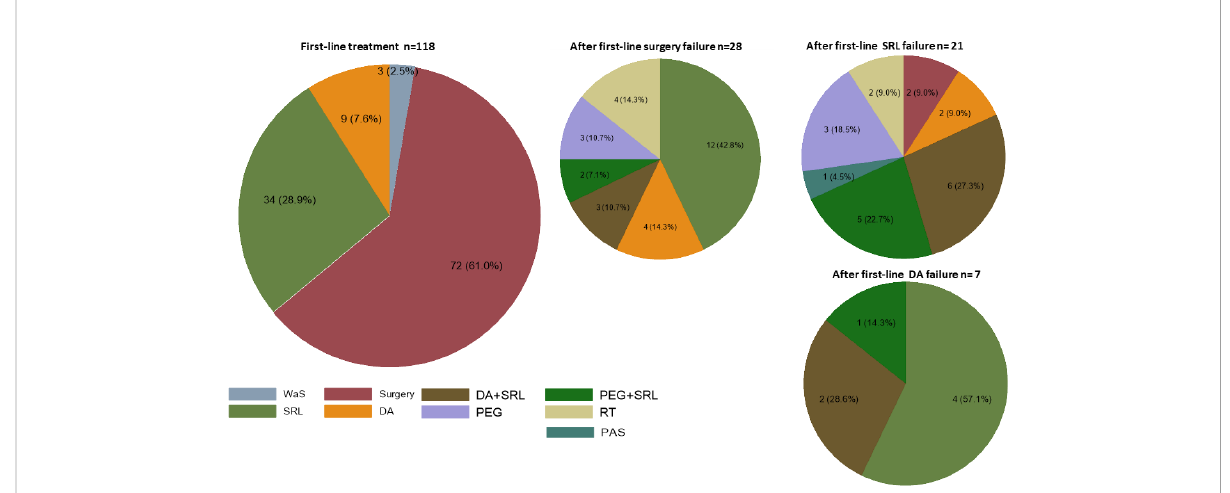
FIGURE 1 Treatment options. First-line on the left and second-line on the right. Results are expressed in “ n ” and percentage. WaS (wait and see) SRL, fi rst generation somatostatin receptor ligand; DA, dopamine agonist ( all cabergoline); PEG, pegvisomant; PAS, pasireotide; RT,